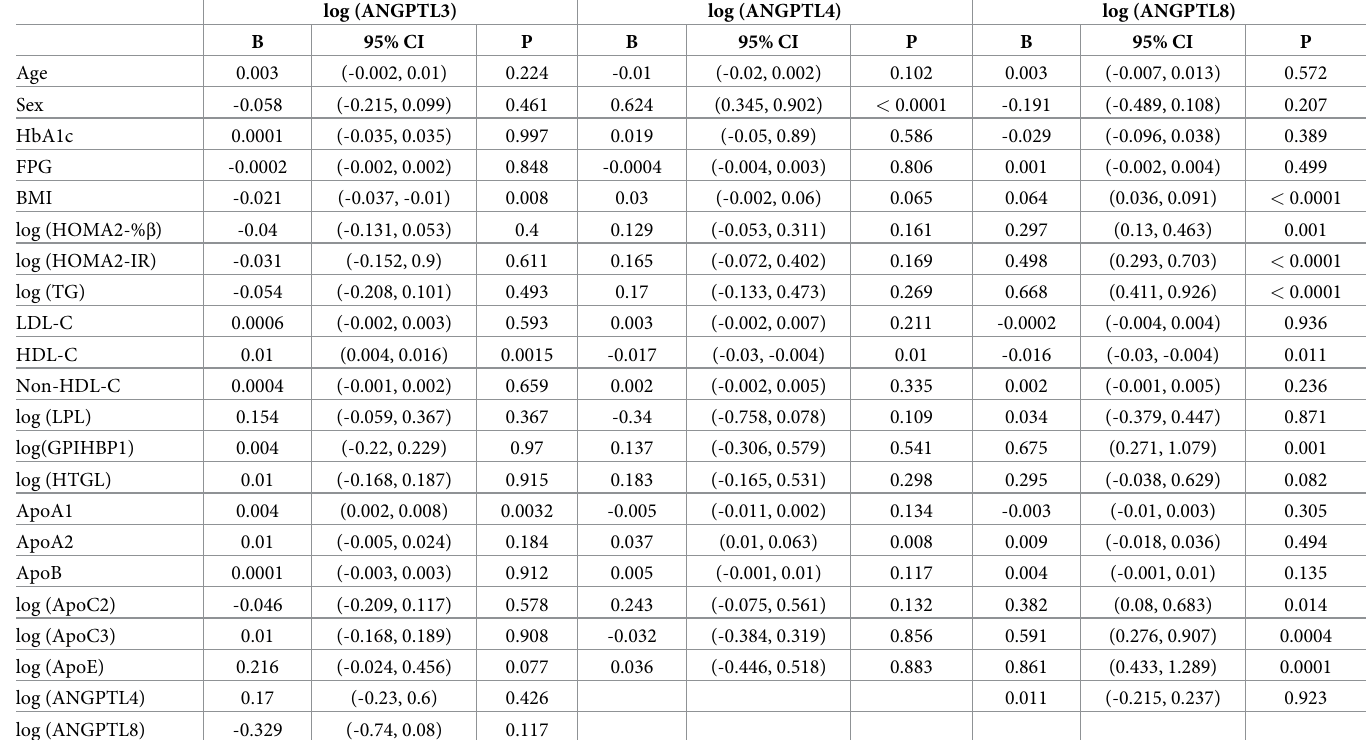
Table 3. Association between lipid and glucose parameters and ANGPTL3, 4, and